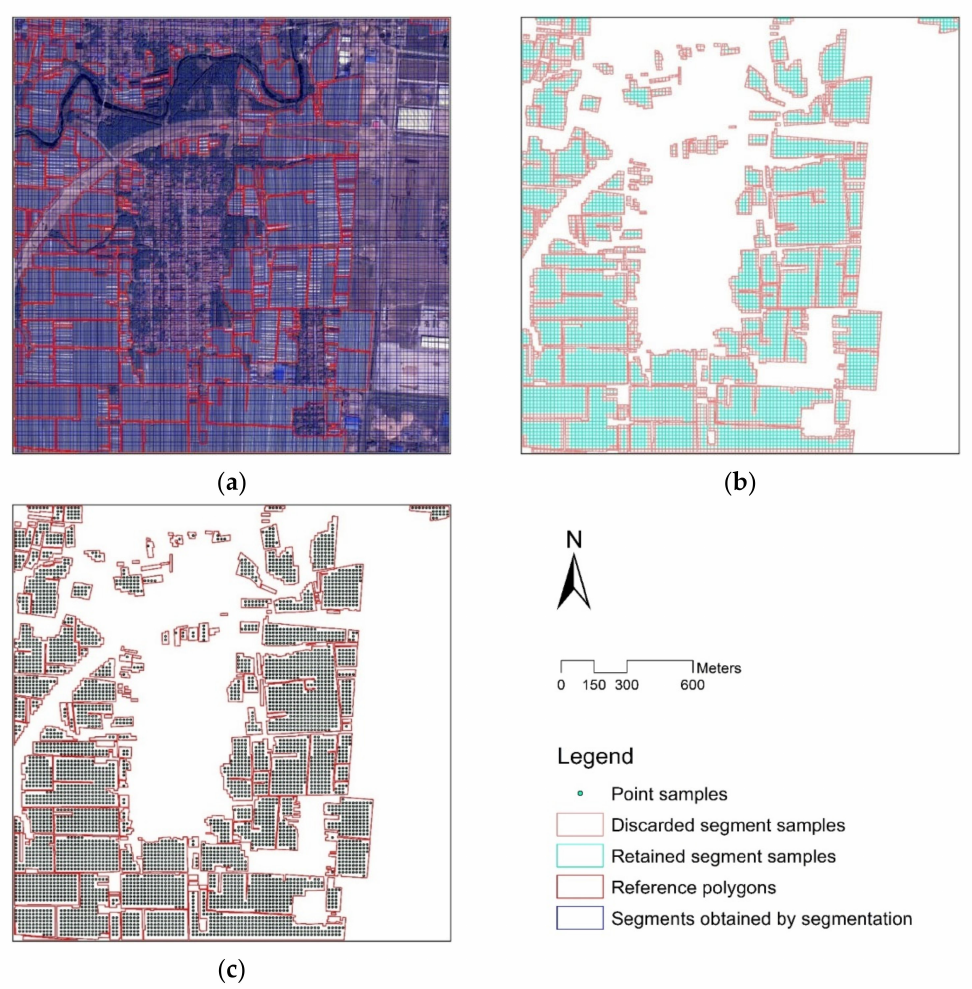
Figure 3. Production of point samples based on reference polygons: ( a ) chessboard segmentation combined with reference polygons; ( b ) discarded and retained segment samples after filtering; ( c ) relationship between point samples and reference polygons.